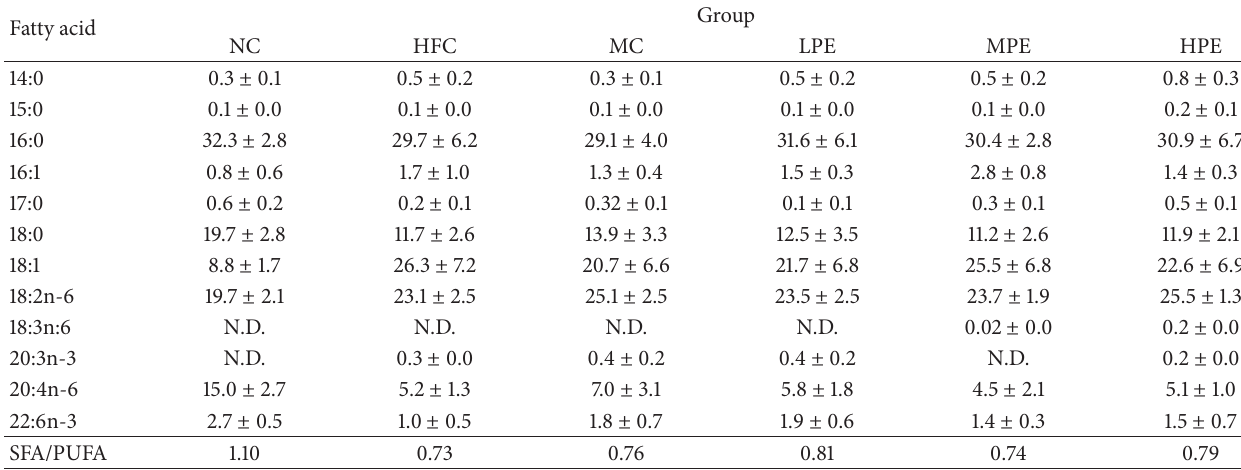
Table 4: Fatty acid composition of liver lipids [ 𝑛 = 10